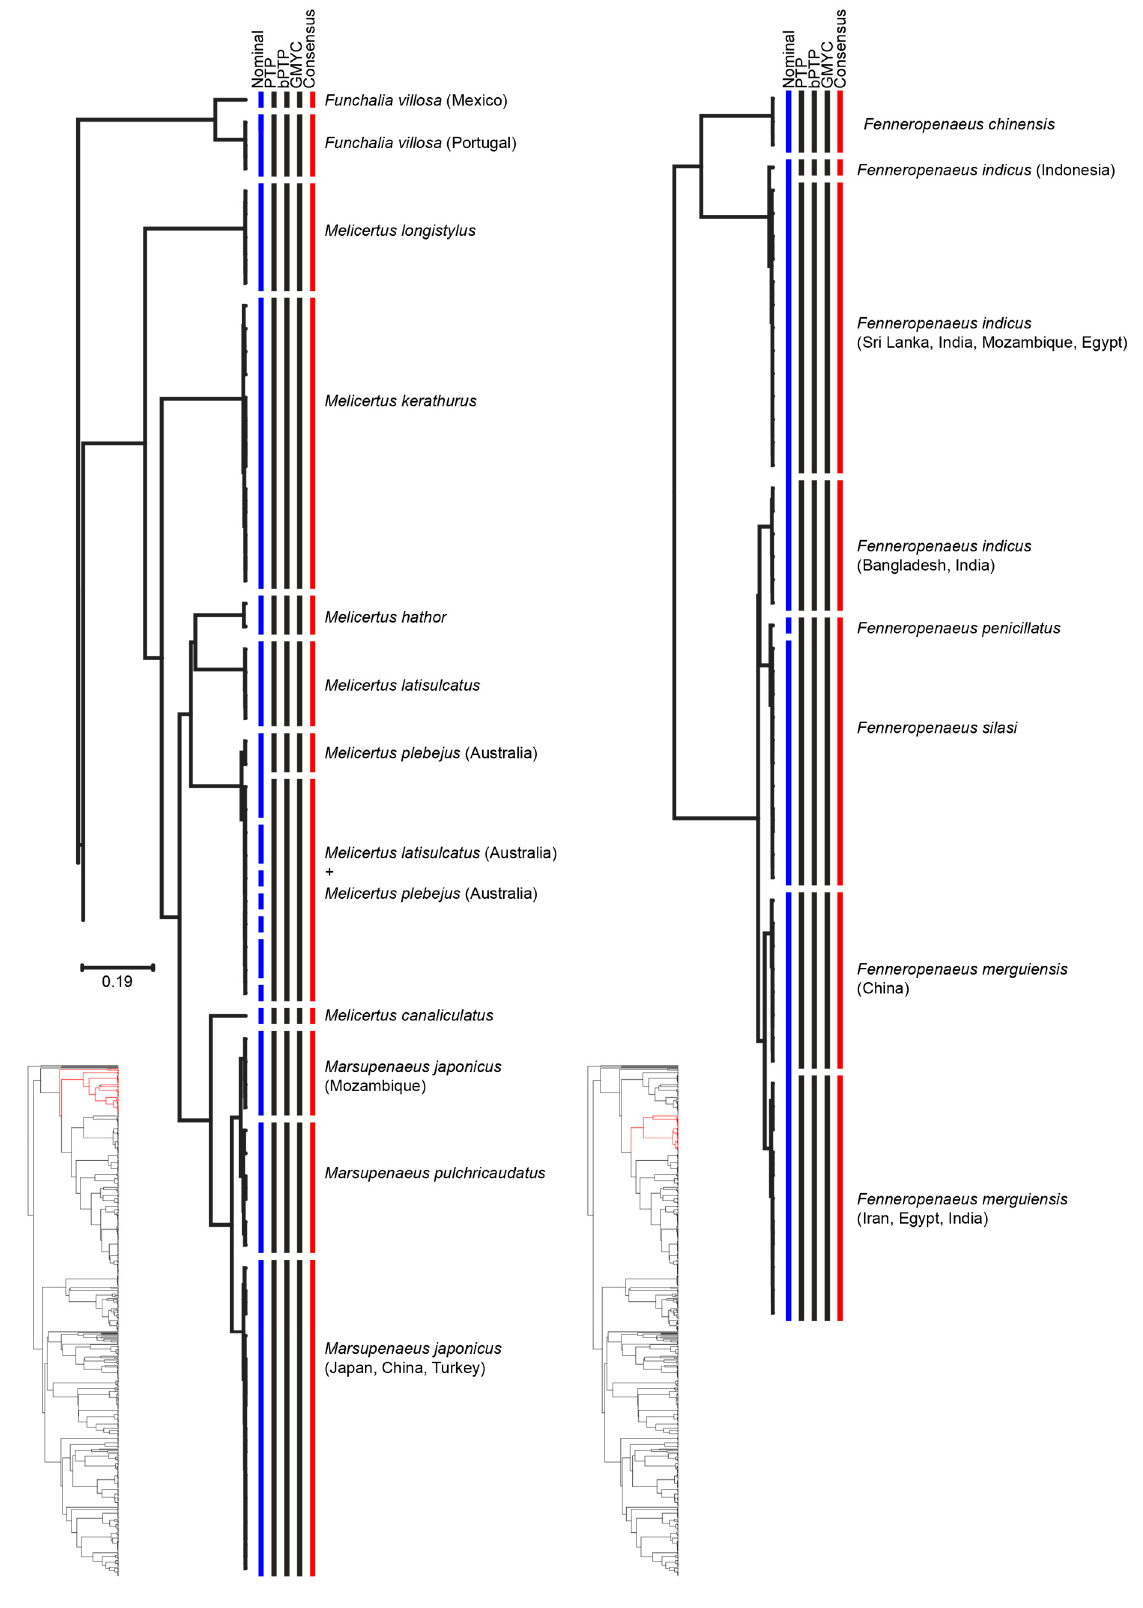
Figure 1. Bayesian tree showing the clustering of the MOTUs obtained by the species delimitation analyses for the genera Fenneropenaeus , Funchalia , Marsupenaeus , and Melicertus .